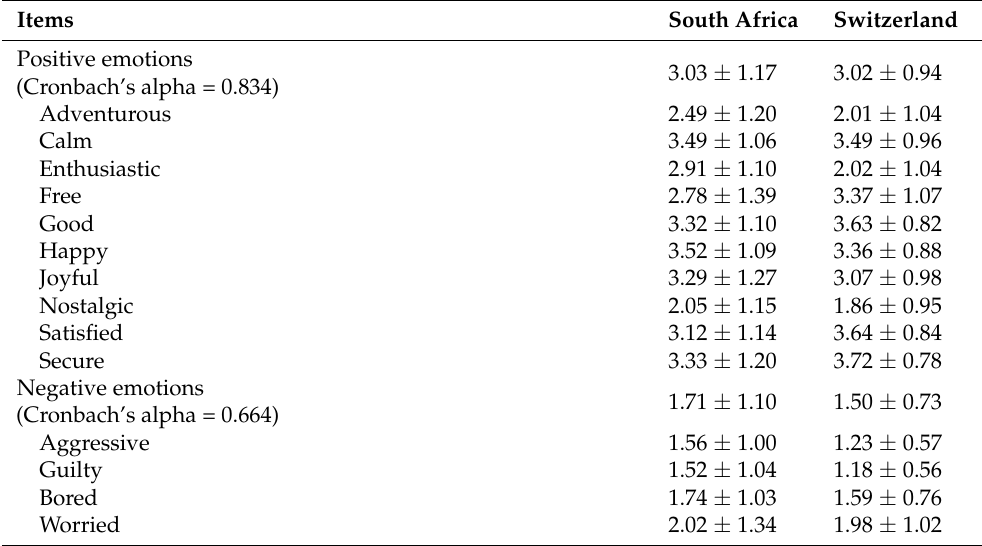
Table 2. Mean and standard deviation (m ± sd) values of consumers’ emotions before biscuit consumption.